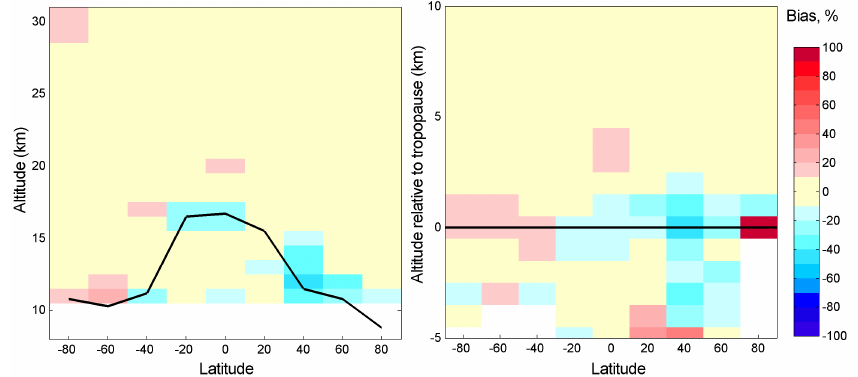
Figure 11. As Fig. 2 but for GOMOS ALGOM2s ozone profiles.